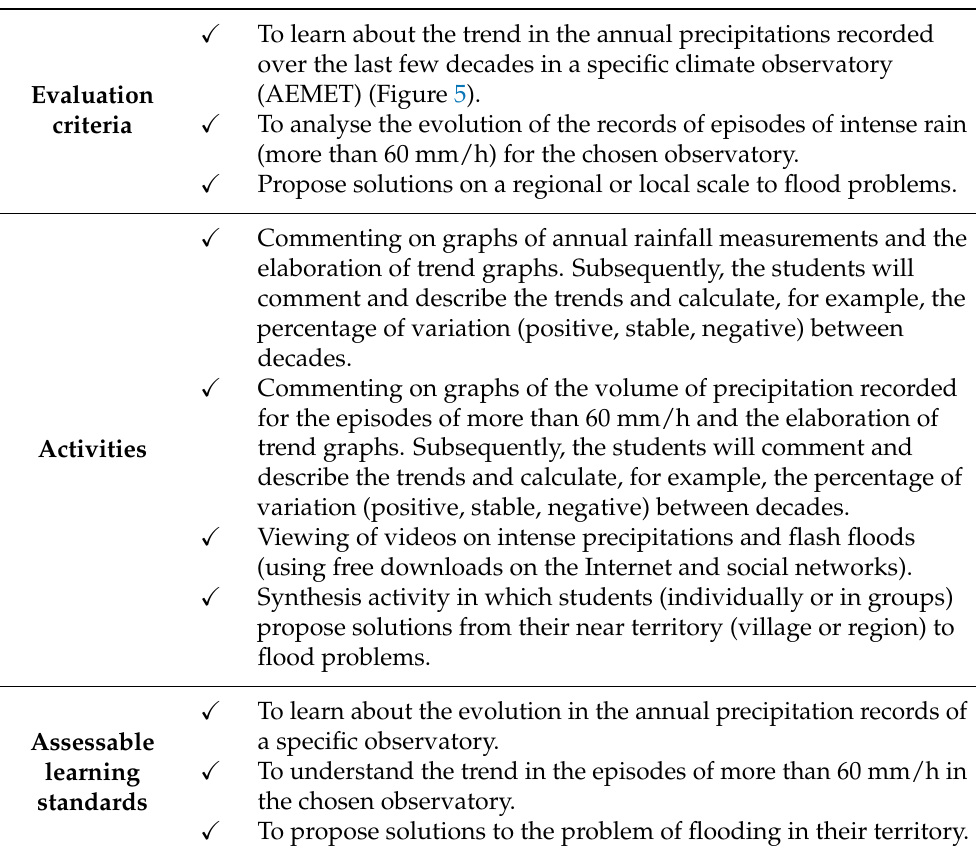
Table 2. Activities proposed for teaching the changes recorded in the precipitation of the Mediter- ranean coast (1st and 3rd of Secondary Education).